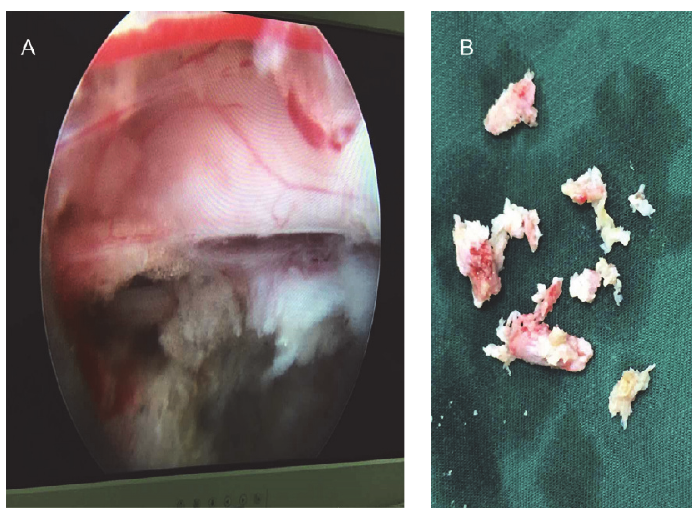
Figure 5: The sight under the endoscope at L4-5 (A); the herniation mass and bone hyperplasia were collected at the plate